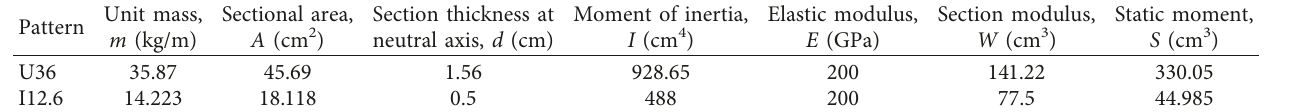
Table 1: Parameters of U36 and I12.6 [29].